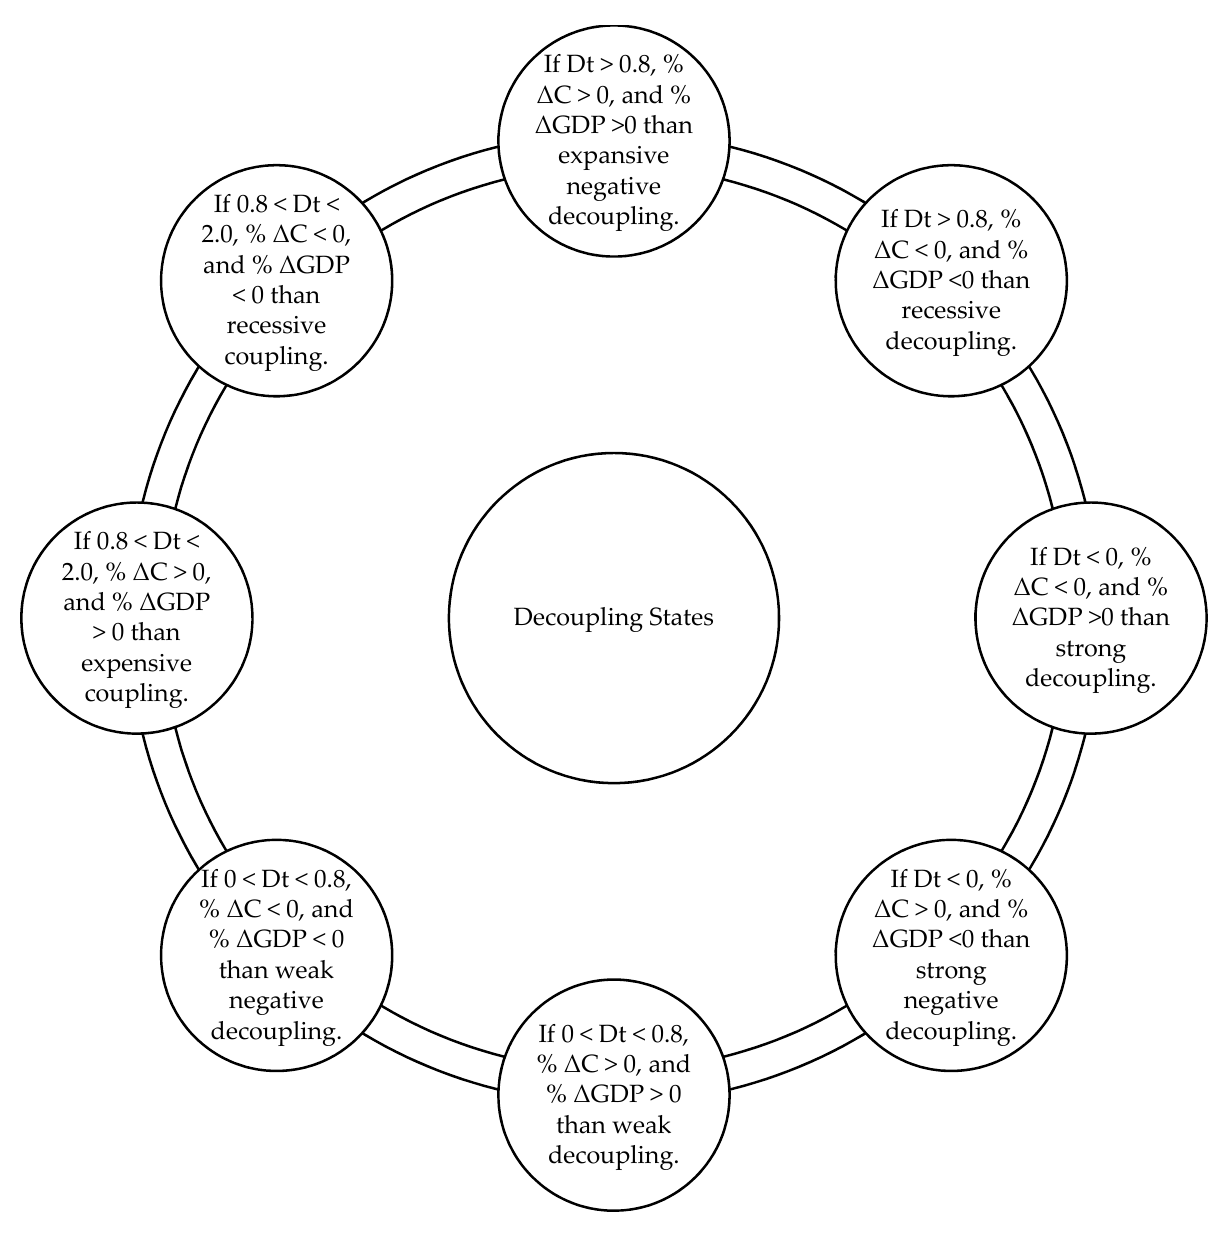
Figure 1. Decoupling States. Source: Tapio (2005) [16]. Decoupling further separates into three subgroups. In weak decoupling, economic development and electricity consumption rise together (and 0 < elasticity < 0.8). Strong decoupling happens when GDP increases and electricity consumption falls (and elasticity < 0). Recessive decoupling shows when GDP and electricity consumption equally decline (and elasticity > 1.2). Likewise, negative decoupling contains three subgroups: in expansive negative decoupling, GDP and electricity consumption rise equally (elasticity > 1.2). In strong negative decoupling, GDP falls, and electricity consumption increases (elasticity < 0). Weak negative decoupling happens when both factors decrease (0 < elasticity < 0.8). Negative GDP growth has been very infrequent in China for several years, and some of the rational likelihoods may appear impractical from the emerging markets perspective, for instance, strong negative decoupling where the growth of GDP drops and electricity consumption rises. However, there seem to be various states in the emerging economies where this perhaps occurred in the